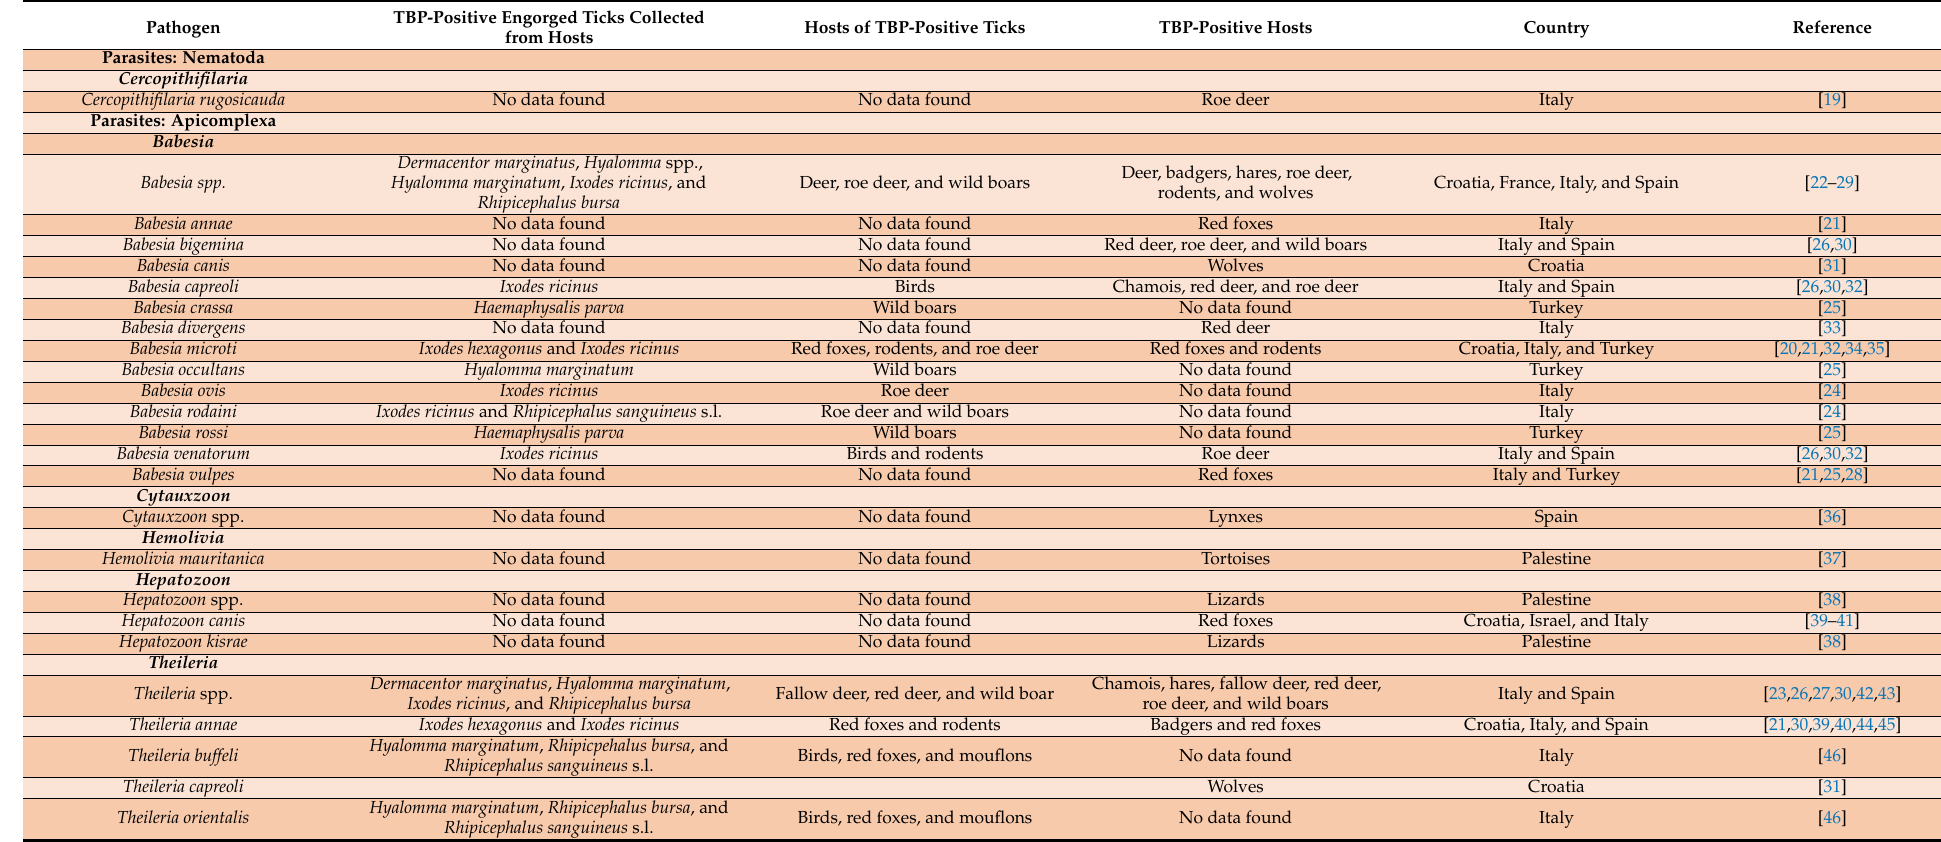
Table 1. Tick-borne pathogens reported in wild animals or engorged ticks found on wild animals in Mediterranean Rim